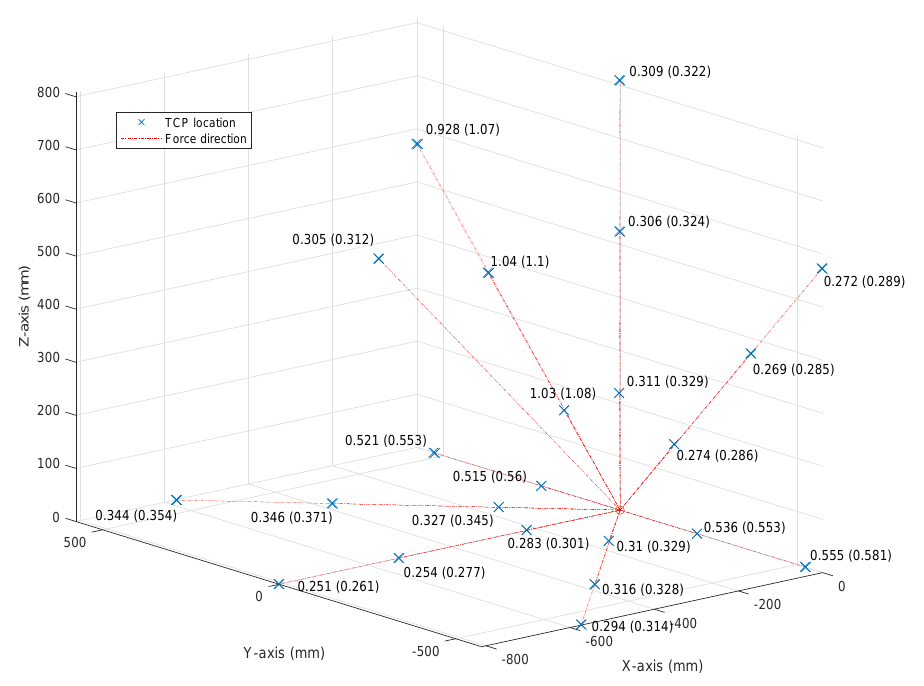
Figure 24: 6-DOF Industrial Robot: Stiffness at different TCP locations. With active servos and (active brakes). 220 mm , 525 mm and 810 mm radius